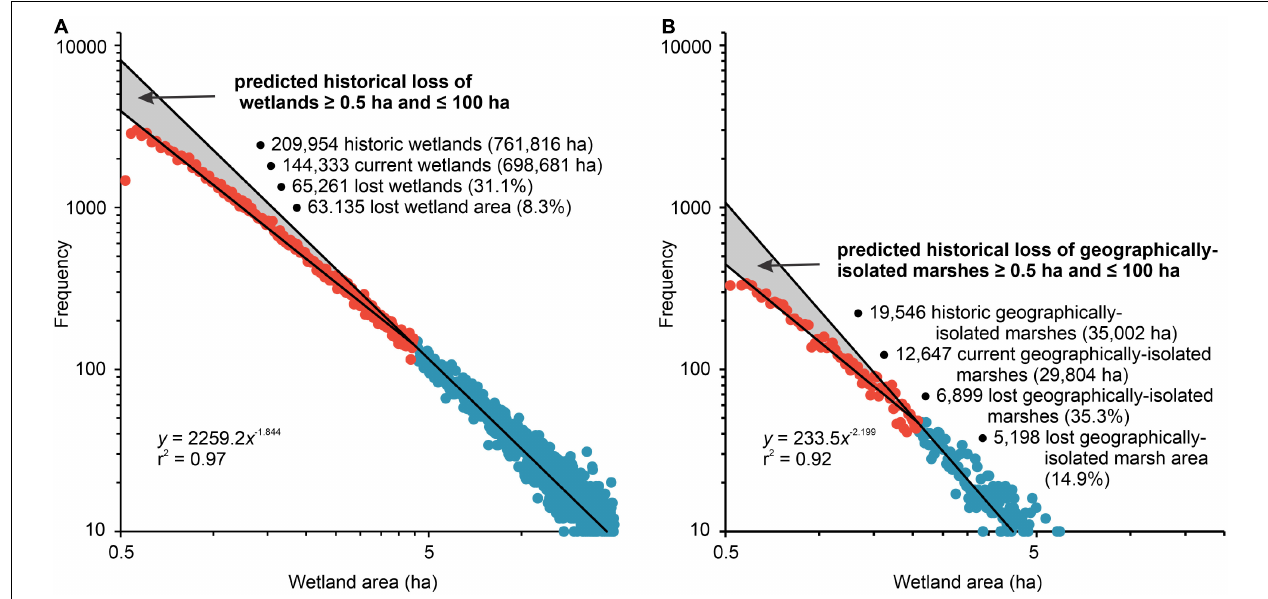
FIGURE 3 | Relationships between area and frequency of wetlands with power-law function trendlines above (“natural distribution” in blue) and below (distribution of wetlands where loss has occurred in red) high frequency breakpoints [gray points represent wetlands above an upper (low frequency) breakpoint in which there are few or no frequency data (these data are not included in the calculation of the natural distribution trendline)]. (A) A total of 63,531 of the 209,954 (31.1%) historic wetland numbers have been lost, representing a total area of 63,135 of the 761,816 ha (8.3%) historic wetland area. (B) For the “easy-to-restore” wetlands, a total number of 6,899 of the 19,546 (35.3%) historic geographically isolated marsh wetlands have been lost comprising 5,198 of 35,002 ha (14.9%) historic geographically isolated wetland area, representing 10.6 and 8.2% of total lost wetland numbers and area, respectively (Data source: Ontario Ministry of Natural Resources and Forestry [OMNRF],